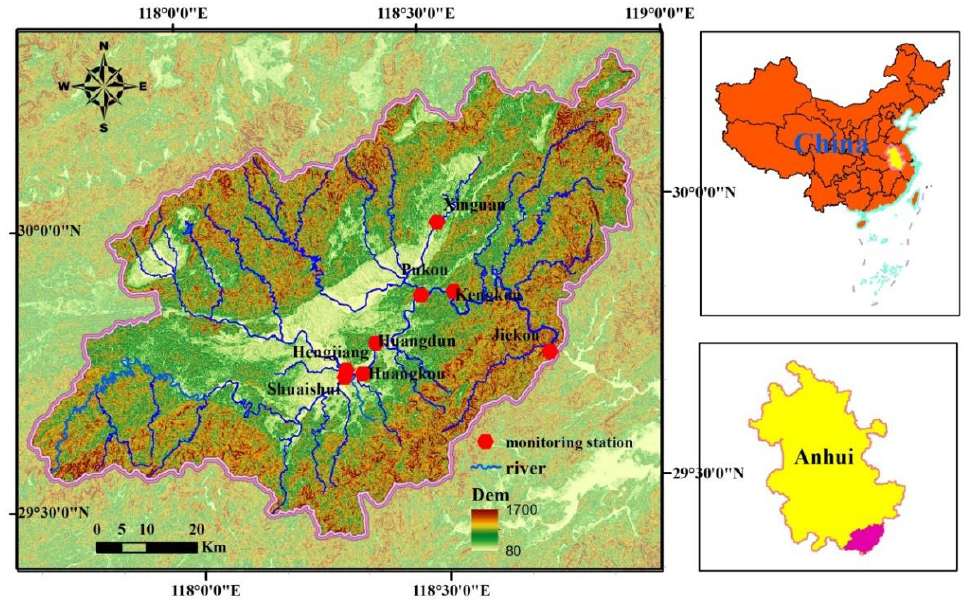
Figure 1. Sample sites distribution in the Xin’anjiang River (Huangshan).